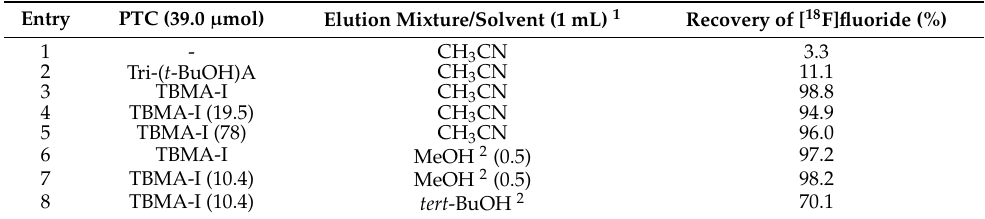
Table 1. Efficiency of 18 F-elution from QMA cartridges using tert -alcohol functionalized amines as